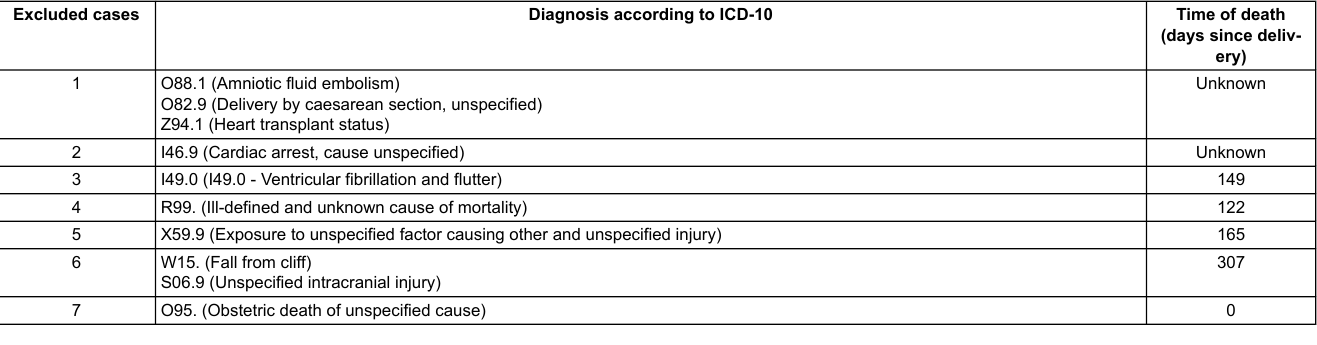
Table 1: The seven cases excluded because lack of information made it impossible to categorise